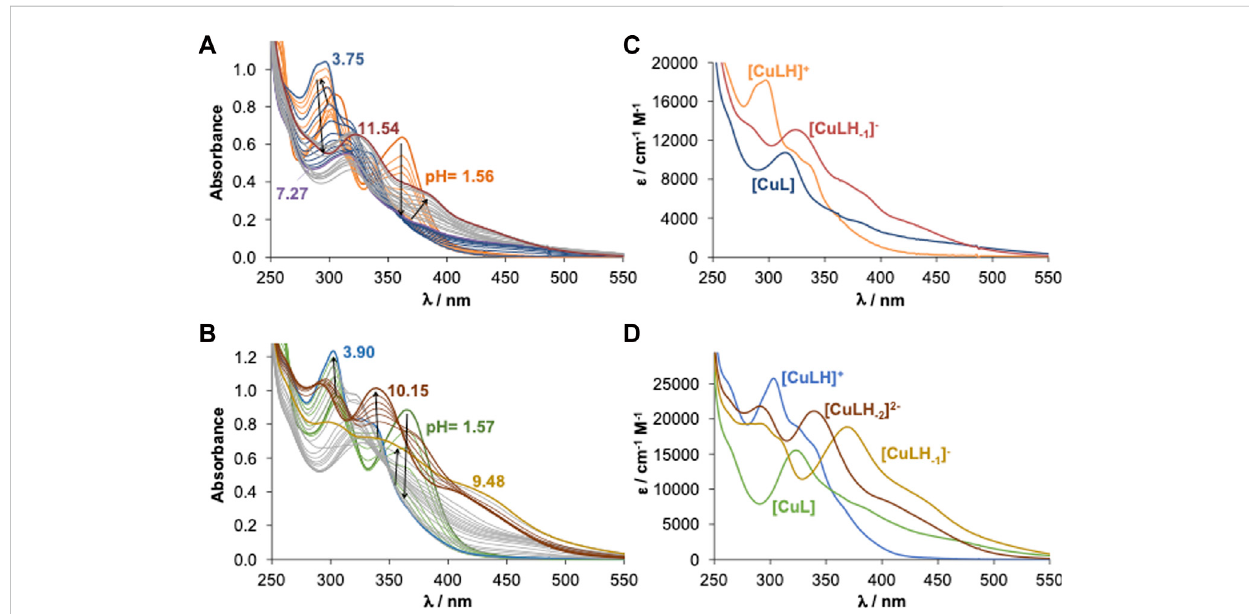
concentrations at pH 7.4, based on the obtained stability constants (Table 3). The higher pCu indicates stronger metal ion binding under the given conditions. These values re fl ect the similar Cu(II)- binding strength of L 1 and L 5 , whereas L 6 forms somewhat lower stability complexes in comparison to the other two ligands, which suggests that the benzohydrazide N 2 im donor is not involved in the coordination in complex 6 . These Cu(II) complexes are the most stable species at physiological pH, with a level of dissociation at 1 μ M concentration corresponding to only ca. 5% for complex 6 . As the complex formation of ligands L 4 and L 6 was also studied with oxidovanadium(IV) the speciation data obtained here for the Cu(II) complexes were compared and detailed in the SI (Supplementary Figure S11B and its legend). It was pointed out that the binding of these ligands to Cu(II) at pH > 7 is much stronger than to oxidovanadium(IV).